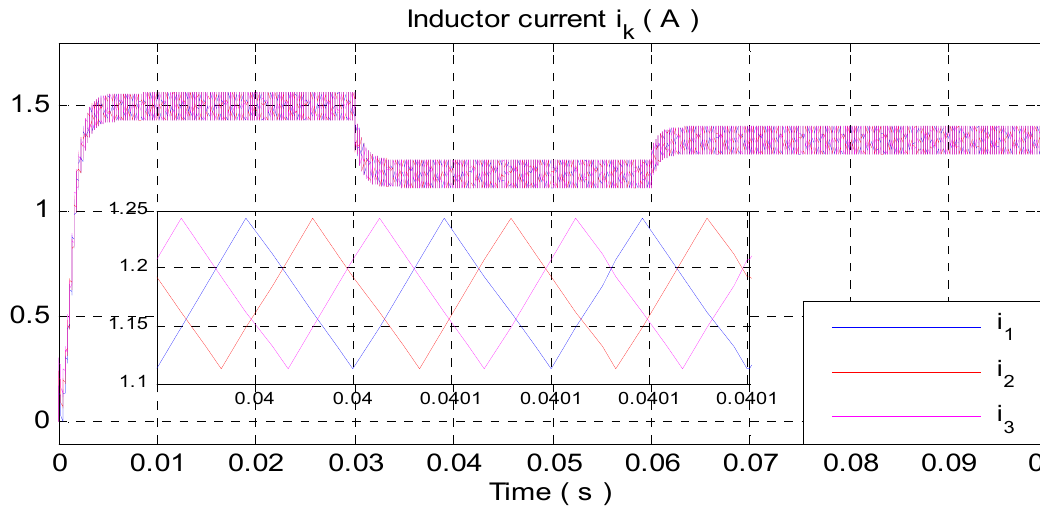
Figure 7. Inductance currents i k of